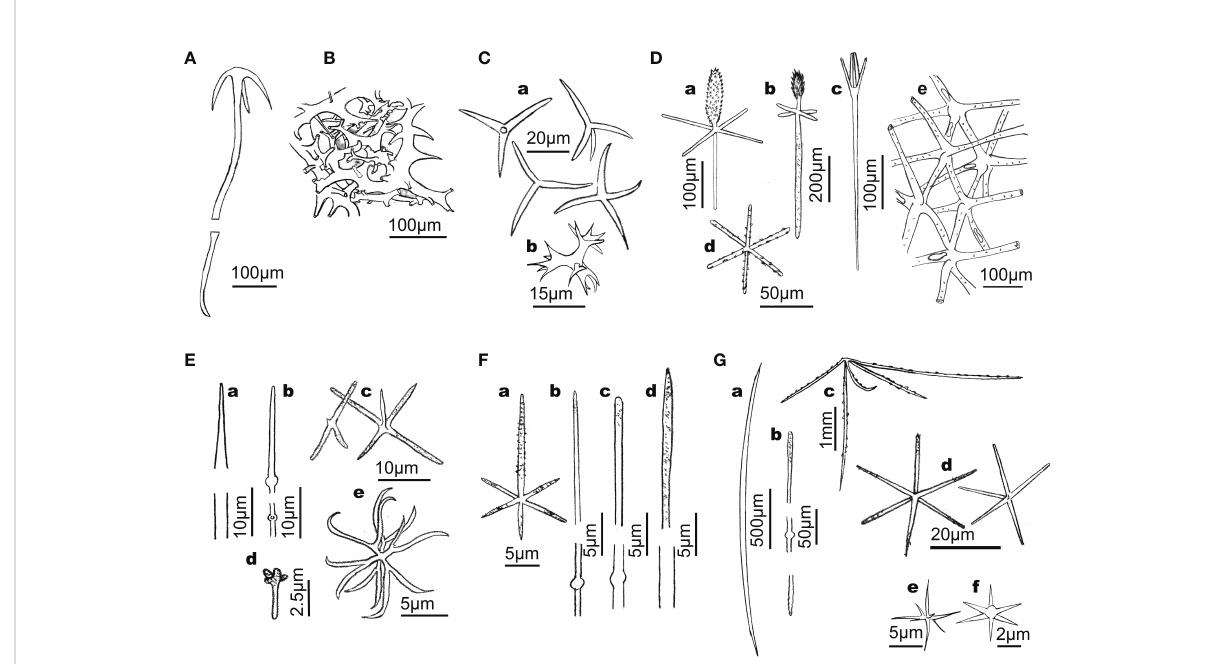
FIGURE 1 Line drawings summarizing the main types of siliceous skeletons involved in the dissolution experiment. (A) Anatriaene from the rootlets of the astrophorid demosponge Geodia hentscheli. (B) Skeletal framework of fused desmas of the lithistid demosponge Leiodermatium pfeifferae . (C) Microtriactines and microtetractines (a) along with candelabra (b) of the homoscleromorph Corticium candelabrum . (D) Skeleton of hexactinellid hexactinosid Aphrocallistes vastus , where a variety of hexactinal spicules (e.g., a, b: dermal pinnule; c: dermal scopule;